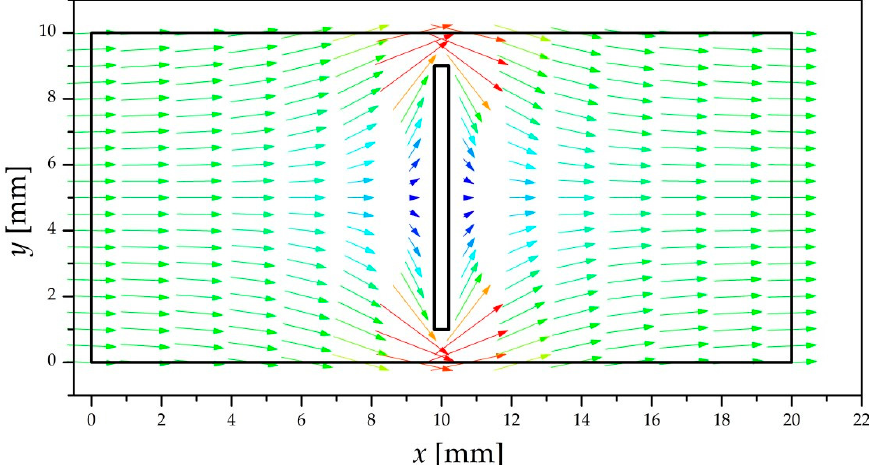
Figure 5. Distribution of the vector of current density for an infinitely thin crack calculated on the basis of Formula (33) for E 0 = 5 V / m, θ = 90 ◦ , a = 8 mm.